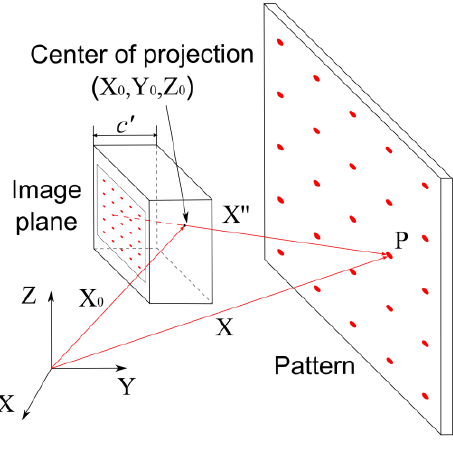
Figure 3. Pinhole camera model.